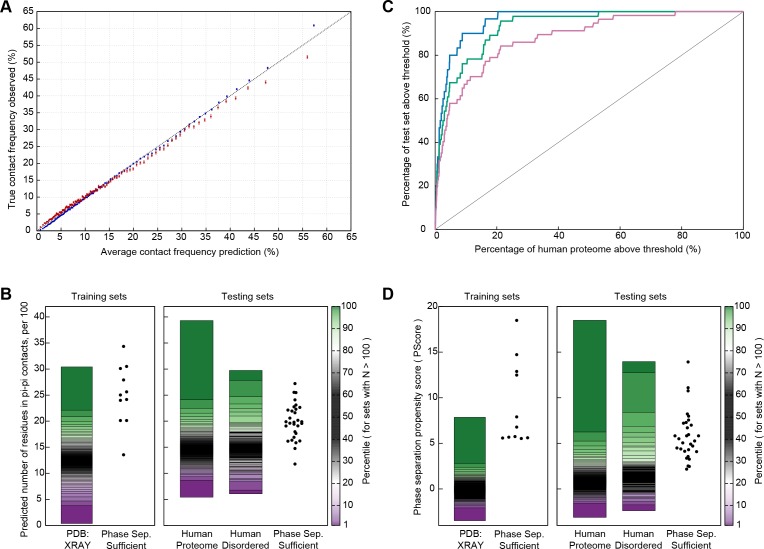
Prediction of phase separation based on planar pi-pi interactions.(A) Reliability plot showing average predicted and observed contact frequencies for percentile bins by pi-pi contact prediction for proteins in the PDB, with PDB sequences used for training in blue and the leave out set in red. Bars show SEM. (B) Highest number of contacts predicted, by window, for two phase separation predictor training sets and three test sets, for the unoptimized predictor. (C) Modified ROC curve showing the final predictor’s performance on three test sets vs. the human proteome, with the full set in pink (N = 62), the full set minus the insufficient for phase separation set shown in green (N = 44), and the sufficient for phase separation set in blue (N = 32). (D) Results for the final predictor (as for panel b) plotted with the predictor’s phase separation propensity scores (PScore). Data underlying B-D included in Figure 5—source data 1 and Figure 5—source data 2.10.7554/eLife.31486.015Figure 5—source data 1.Phase separation training, testing and designed protein test sets.Excel table containing identification and literature references for proteins in the phase separation test and training sets, with sheet one showing the training set proteins, two showing proteomic test set proteins, and three showing synthetic test set proteins.
10.7554/eLife.31486.016Figure 5—source data 2.Additional phase separation propensity scores used in final ROC analysis.Excel table containing protein IDs and predicted propensity scores, with different datasets on each sheet. Sheets 1–3 have full predictions for the human, E. coli, S. cerevisiae proteomes, respectively. Sheet four repeats the subset of human proteins found in the DisProt database. Sheet five shows scores for the protein sequences found in our non-redundant PDB set, and sheet six repeats the subset of PDB sequences withheld from predictor training.